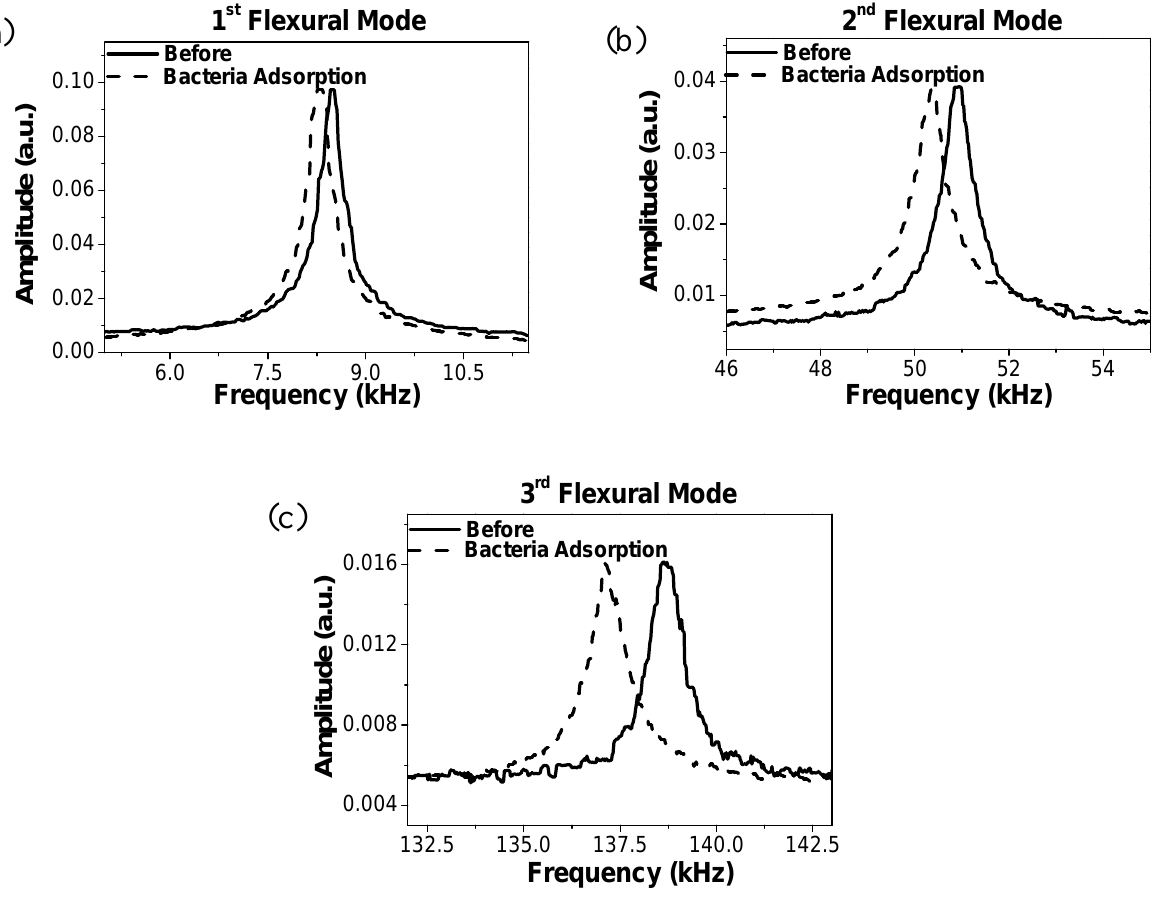
Figure 5. Spectra of the Brownian motion of the cantilever before (solid line) and after (dashed line) bacteria